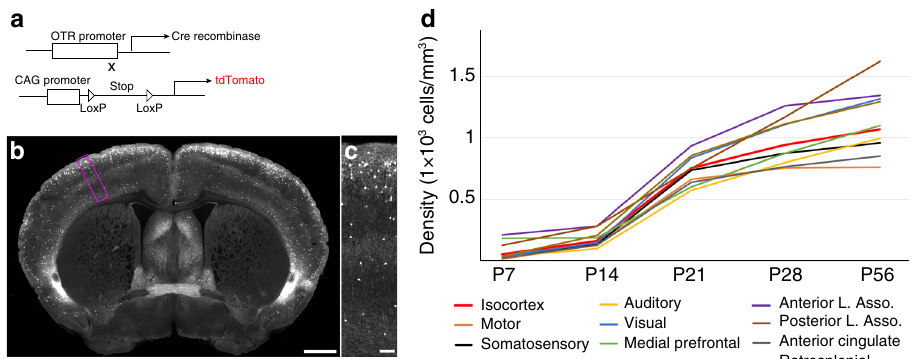
Fig. 4 OTR downregulation is largely driven by receptor downregulation. a Experimental design to permanently label transient OTR-positive neurons by crossing Otr-Cre with Cre-dependent reporter mice ( Otr-Cre :Ai14). b Example of an adult Otr-Cre :Ai14 brain. Scale bar = 1 mm. c High magni fi cation image of purple boxed area in b . Scale bar = 100 μ m. Note the abundant tdTomato-positive cells in the upper layer from the developmental labeling. d Average density of tdTomato ( + ) cells in different isocortical regions at different developmental